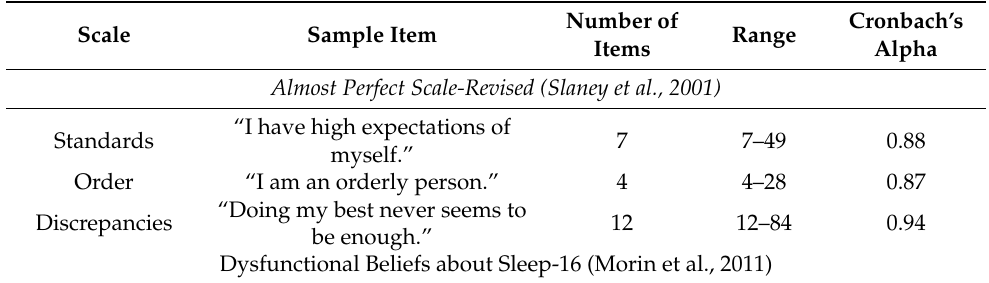
Table 1. Subscale information for the APS-R and